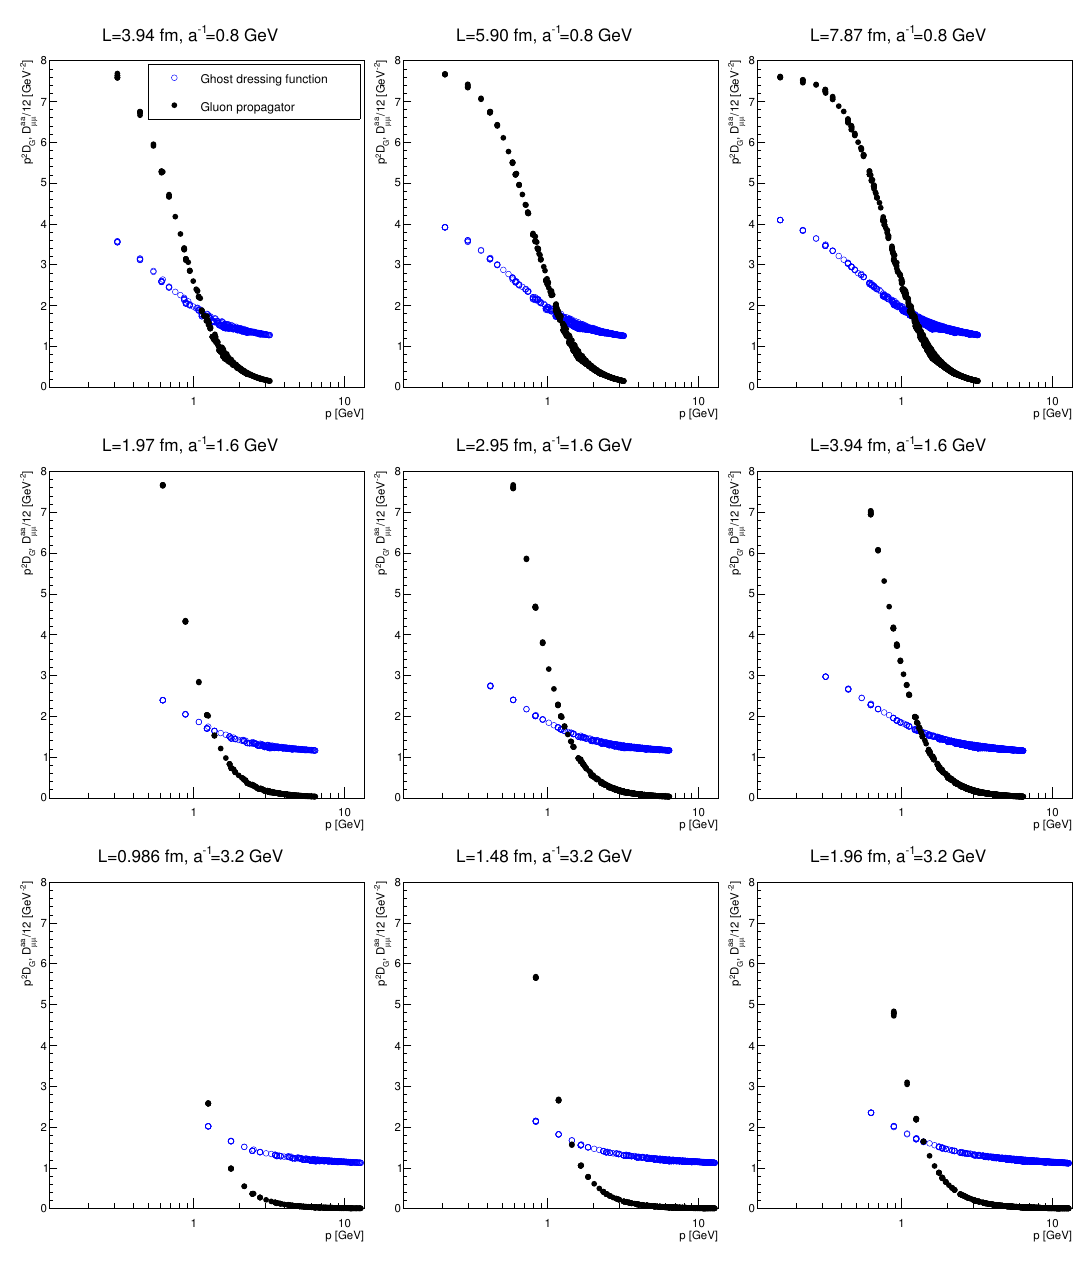
Figure 10: The ghost dressing function and the gluon propagator for the different lattice settings in four dimensions. Lattice volume increases from left to right and the latte spacing decreases from top to bottom. Results are along all possibles axes [ 40 ] . Errors are smaller than the symbol sizes, and the same number of configurations have been used in both cases. The results have not been